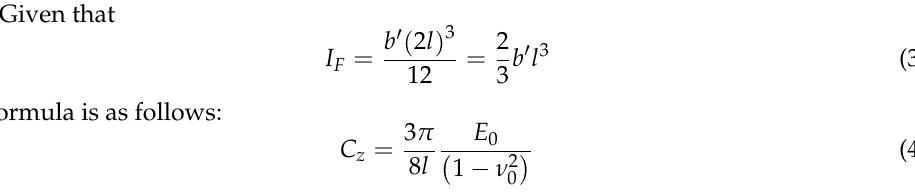
0 Figure 3. Example of settlement curves for a single pile. According to the above scheme, the calculation represents an approach for the design of pile foundations that abandons the classic concept of pile bearing capacity expressed in terms of force and gives more weight to the amount of settlement by obtaining the load – settlement ( Q – s ) characteristics of the pile. This design concept is easier to apply than the classical approach. An example of such an approach is a method based on theoretical load transfer functions [20,21] by Bateman et al. [25]. The empirical load transfer functions are of limited use, while the theoretical functions are more attractive because of the univer- sality of the solution, which is the approach used in the method presented in [26,27]. In foundations that are a group of piles, the interaction between the piles must addi- tionally be taken into account. This is a significant issue in itself [28 – 31], but with the use of the load transfer function method, it is reduced to a modification of the original function for a single pile. The settlement of adjacent piles is due to the settlement of a single pile loaded by an axial force and the interaction between the piles. This results in higher settlements of piles in a group ( s ij ) compared to settlements of the same piles considered as single piles ( s i , s j ), as shown in Figure 4.